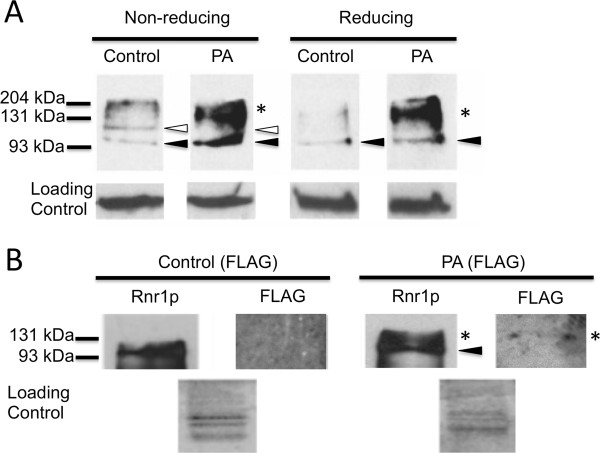
The PA incompatibility domain interacts with yeast Rnr1p. A) Proteins were extracted from PA-expressing and control yeast cells grown in YPD. Under non-reducing conditions, proteins extracted from PA-expressing yeast contained a lower amount of oxidized (open arrow) Rnr1p and a greater amount of reduced Rnr1p (solid arrow) compared to the control strain. As expected, oxidized Rnr1p in control strain is converted to the reduced form when proteins are extracted under reducing conditions. An intense band at 155 kDa (*), inferred to be a non-reducible PA (FLAG)p-Rnr1p complex (see Panel B), was observed in proteins extracted from PA(FLAG)-expressing yeast. Equal loading across lanes was based on Bradford assays and verified by a non-specified protein that reacted with the anti-Rnr1p polyclonal antibody (loading control). The images shown here are taken from one blot and as such exposure times are the same across all lanes. Similar results were observed in three independent experiments. B) Proteins were extracted under native conditions from PA-expressing and control yeast grown in YPD and subjected to size exclusion chromatography. Following fractionation, proteins were precipitated and concentrated, and treated with reducing agents before use in immunoblots. Co-fractionation and co-localization of the PA(FLAG)p (detected by anti-FLAG antibodies) and Rnr1p (detected by anti-Rnr1p antibodies) provides evidence for a 155 kDa PA(FLAG)p-Rnr1p complex (*) in Fraction 3 of the PA(FLAG) strain but not the control. Note that the range of proteins included in Fraction 3 is from 238 kDa to 55 kDa as determined by the elution of a HiMark pre-stained HMW Protein Standard (Invitrogen, not shown). Solid arrow indicates reduced form of Rnr1p. Equal loading was confirmed using a Coomassie stained duplicate gels. Molecular size markers are indicated at the left in both panels.